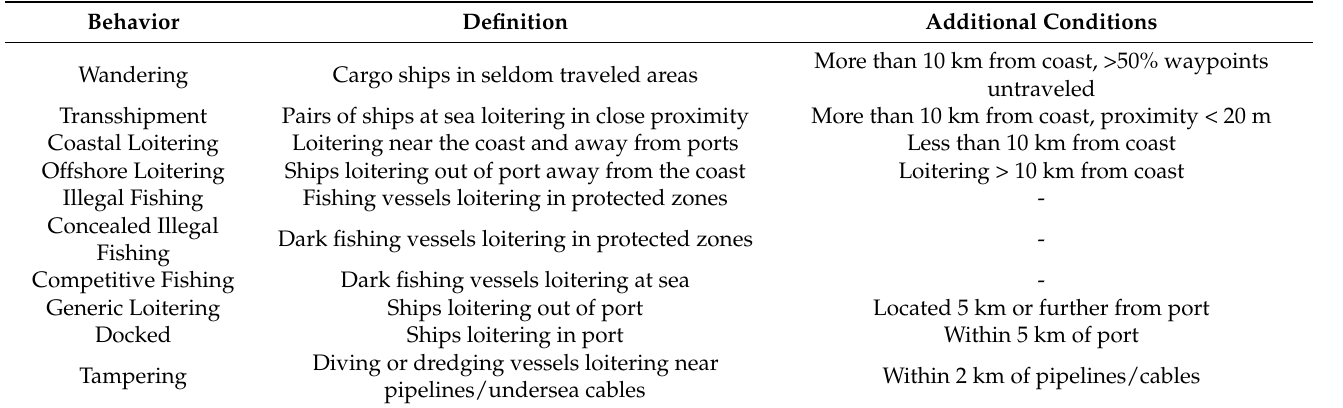
Table 3. Labeled Behaviors within Ship Data and Their